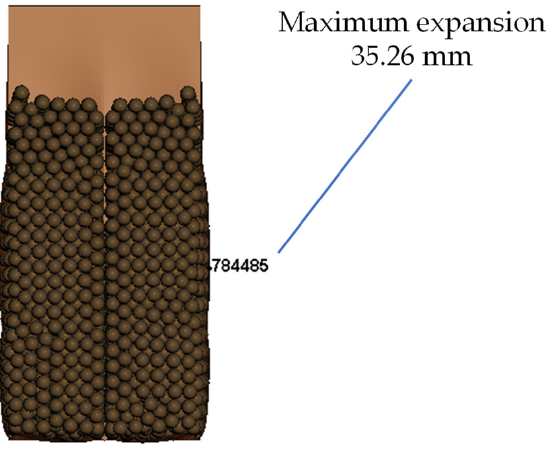
Figure 8. Radial expansion of containment boundary.